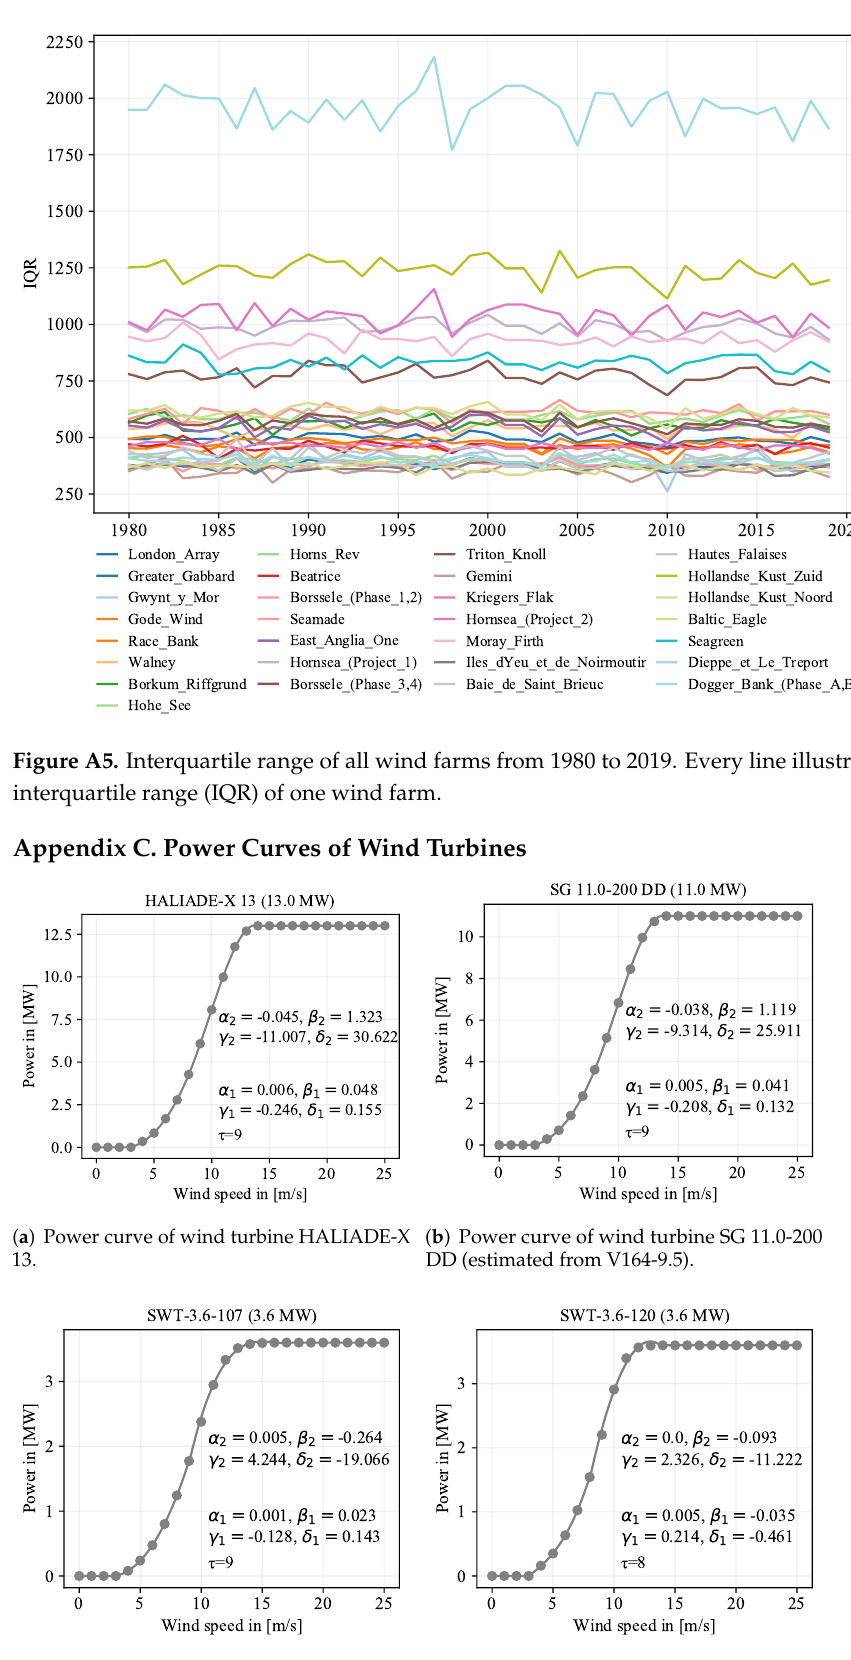
( c ) Power curve of wind turbine SWT-3.6-107. ( d ) Power curve of wind turbine SWT-3.6-120. Figure A6. Cont